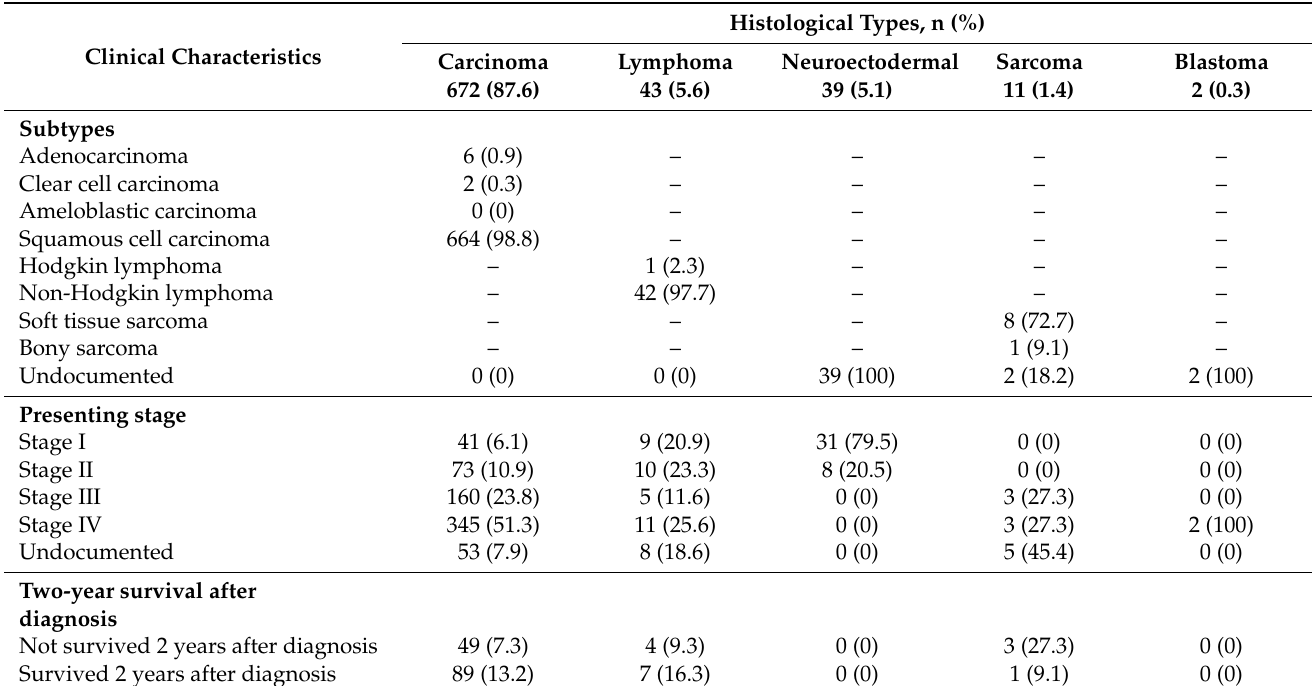
Table 3. Distribution of clinical characteristics by histological type of HNCs, n = 767.